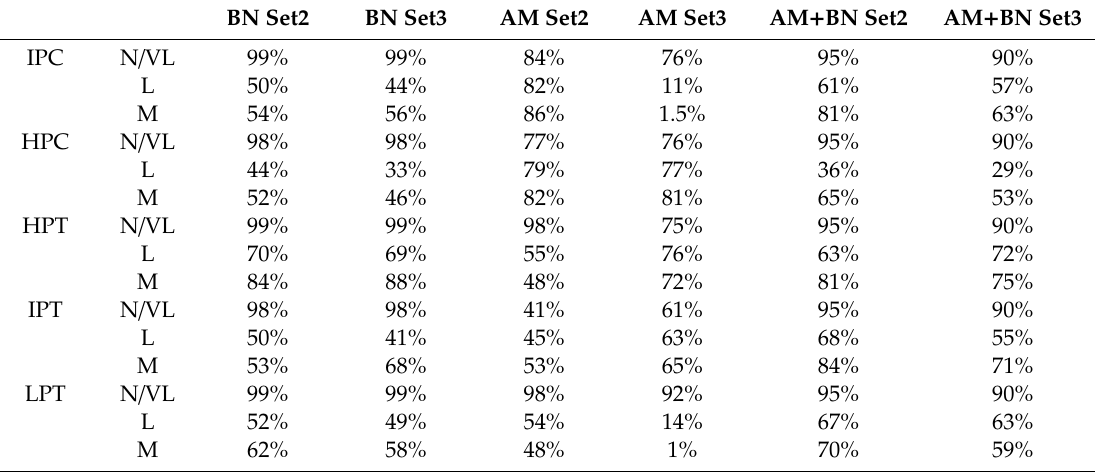
Table 10. Identified faults with di ff erent sensors sets and production scatter.